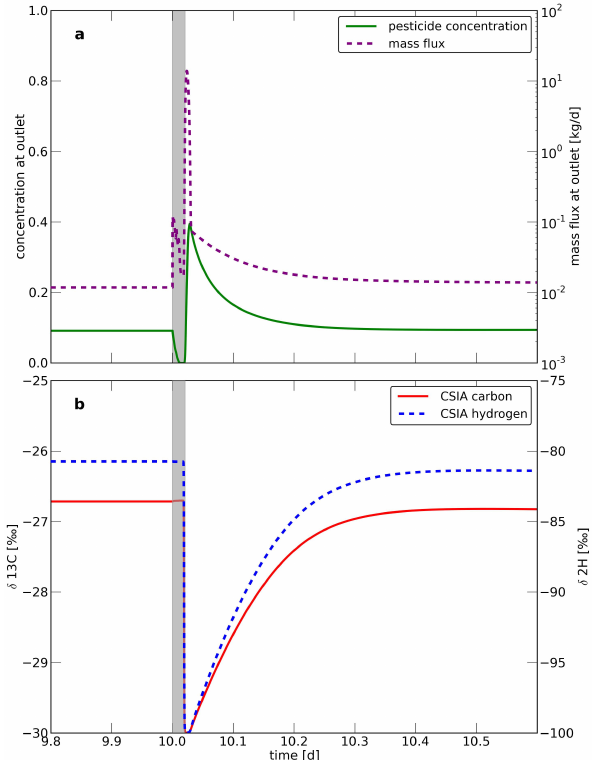
Fig. 4. Response to the extreme rainfall event at the hillslope outlet immediately before and after the rainfall event: pesticide concentra- tion and mass flux ( a , note the logarithmic scale for the mass flux); and carbon and hydrogen isotope ratios of the pesticide (b) . The timing of the rainfall event is shaded in